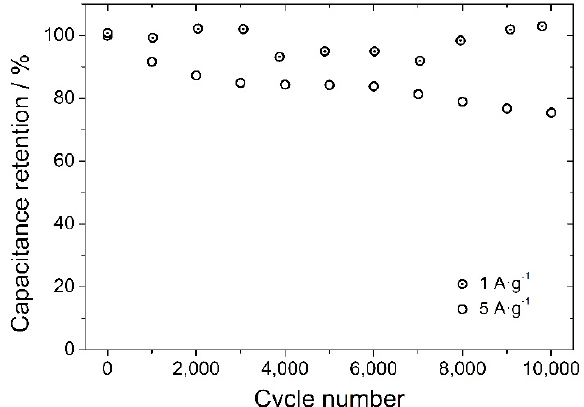
Figure 7. Cycling stability at different current densities (1 and 5 A·g − 1 ) of MnO 2 /GNWs sample annealed at 70 °C. At 1 A·g − 1 , the capacitance retention remains almost constant and around 100% throughout 10k cycles. At 5 A·g − 1 , capacitance retention decreases down to 75% after 10k cycles and the coulombic efficiency is >98% throughout the whole measurement for both current densities.